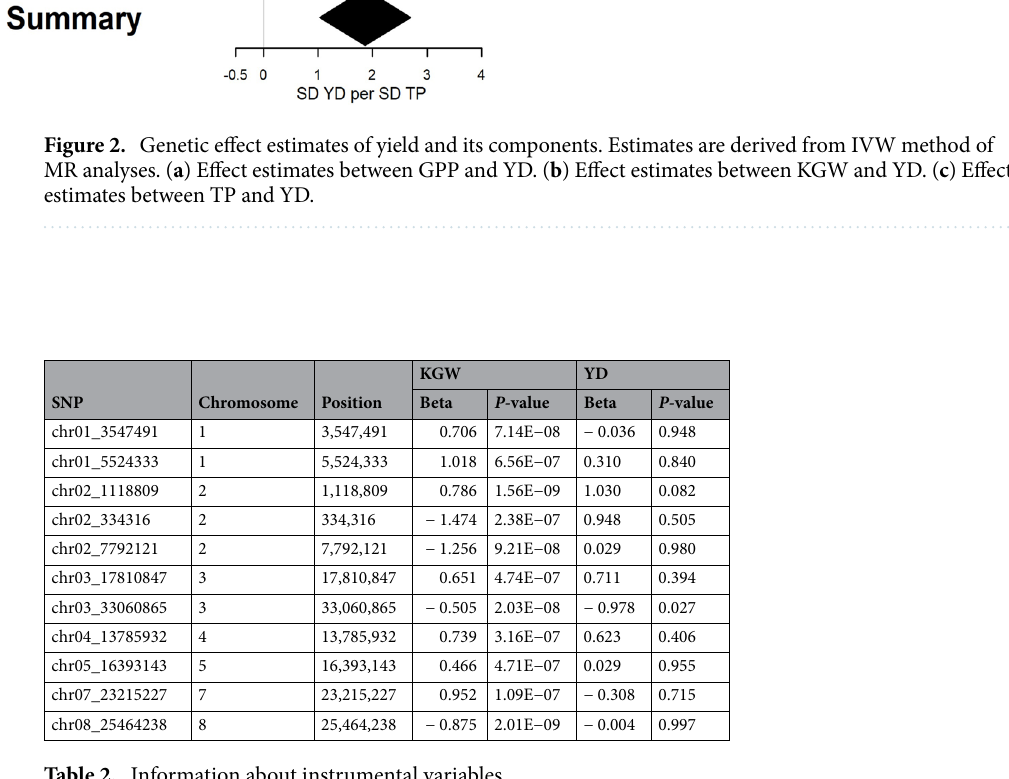
Table 2. Information about instrumental